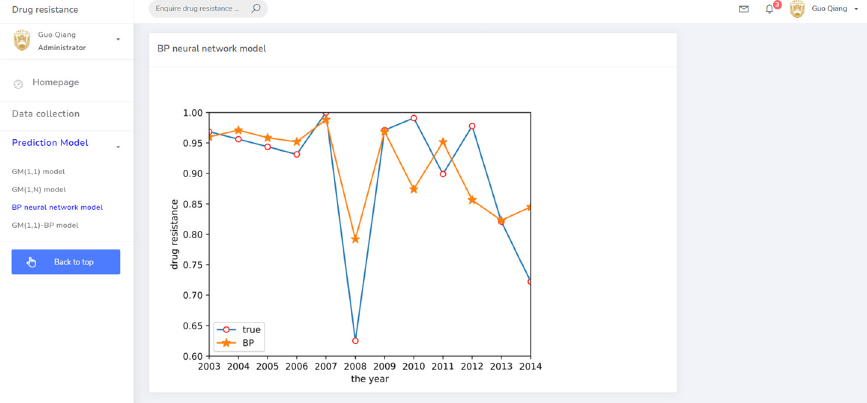
Figure 10. The prediction system page for the BP neural network model.